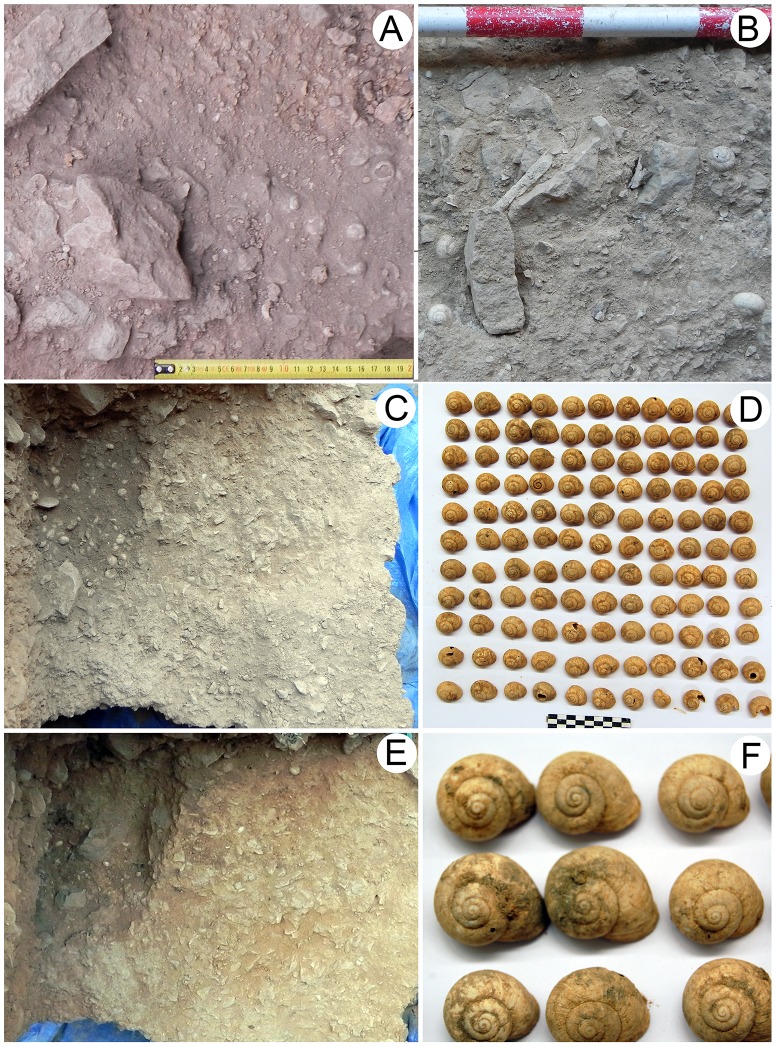
Cultural accumulations of I. alonensis land snails.(A) Spatial association of land snails to carbonaceous sediments and fire-cracked stones of combustion structure EC-1, (B) spatial association of land snails, bone fragments and lithic artifacts of level C, (C) combustion structure BM containing land snails and homogenous carbonaceous sediments; (D) land snails found into the combustion structure BM, (E) morphology of the combustion structure BM once excavated (maximum length 41 cm), (F) burning traces of I. alonensis found into the filling sediment of combustion structure BM.